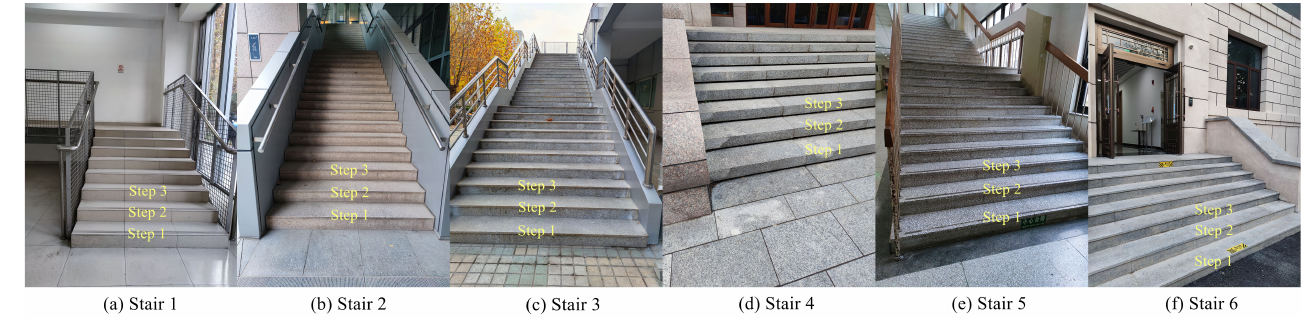
Figure 9. Experimental scenes of the stair geometric parameter estimation